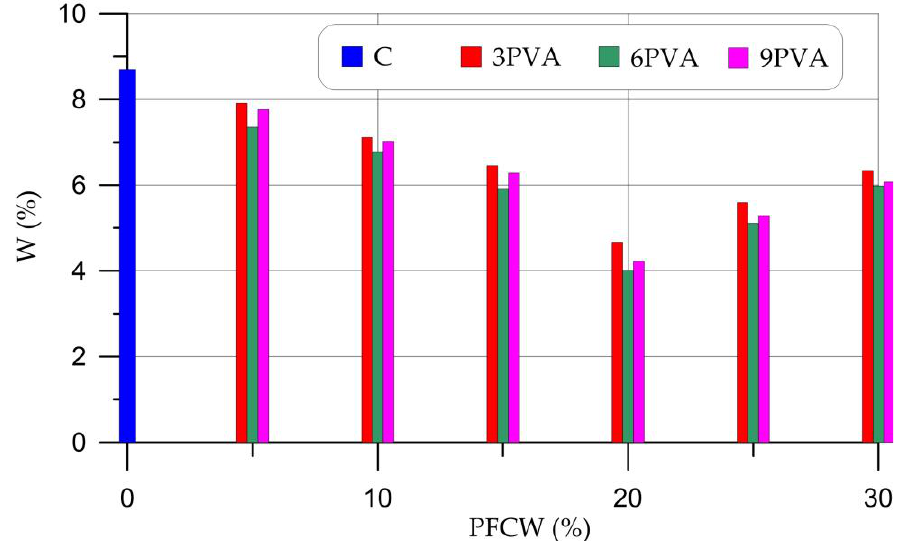
Figure 9. Water absorption of samples of geopolymer concretes with different percentages of replacement of metakaolin with PCW and different dosages of PVA.